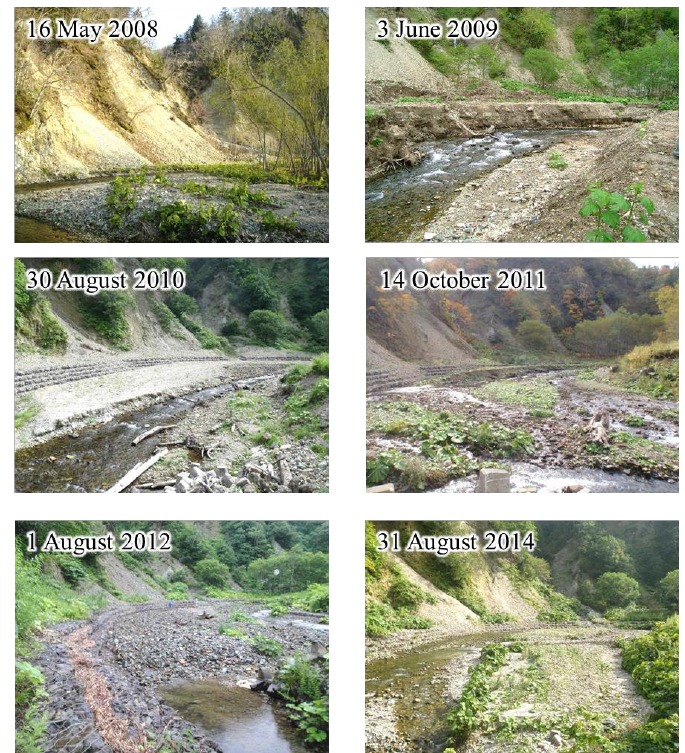
Figure A1. Upstream view from the check dam before (16 May 2008) and after (3 June